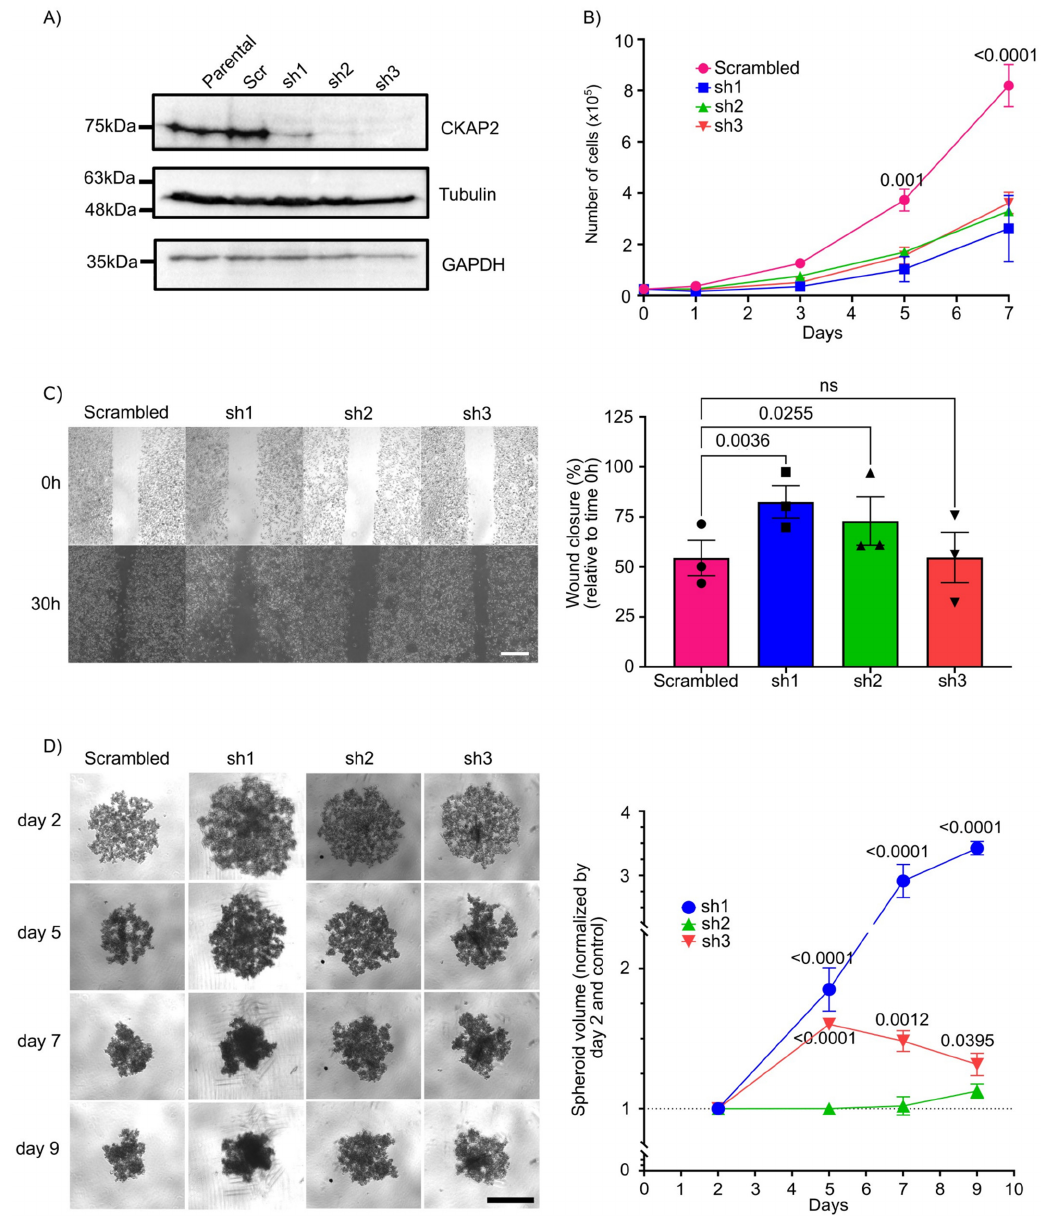
Figure 8. Effect of CKAP2 knockdown in breast cancer. ( A ) Immunoblot showing CKAP2 protein levels in parental SKBR3 cells and SKBR3 cells that stably express a scrambled vector (control) and three different shRNAs (sh1, sh2, and sh3). Tubulin and GAPDH: loading control. ( B ) Growth curve of CKAP2 cell lines (scrambled, sh1, sh2, and sh3). Data are shown as mean ± SEM. p < 0.05 were considered statistically significant. n = 3 biological replicates. ( C ) Cell migration (wound healing) assay in CKAP2 cell lines (scrambled, sh1, sh2, ad sh3) using IBIDI inserts. Representative images